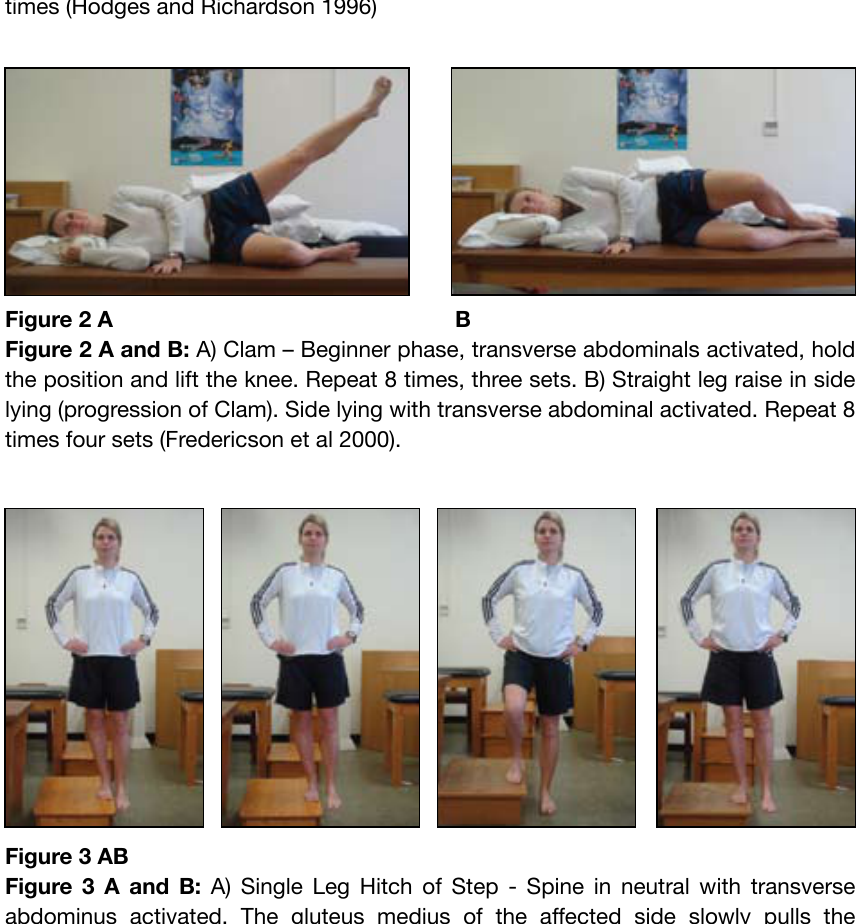
Figure 3 A and B: A) Single Leg Hitch of Step - Spine in neutral with transverse abdominus activated. The gluteus medius of the affected side slowly pulls the unaffected pelvis upwards to neutral spine. Repeat 8 times, three sets. (Fredericson and Weir 2006, Fredericson et al 2000). B) Sideways step up (Progression of Single Leg Hitch). Side step up with transverse abdominal activated. Repeat 8 times, four sets (Fredericson and Wolf 2005, Khaund and Flynn, 2005).